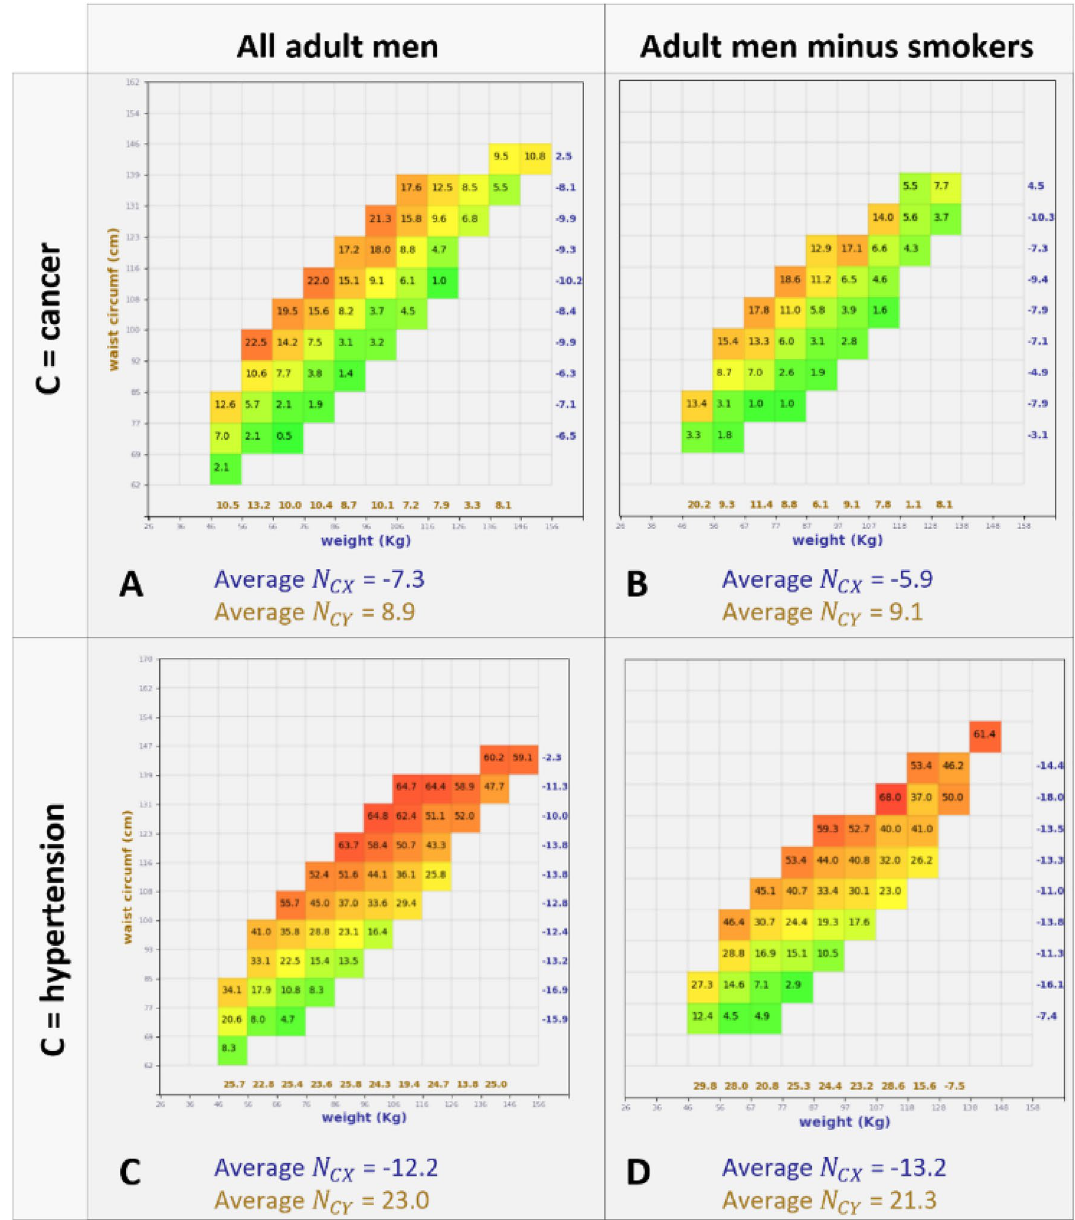
Figure 4. Prevalence maps and average NORSE scores for X = Weight, Y = Waist, C = cancer, for adult men. ( A ) including smokers. ( B ) excluding smokers. ( C , D ) Same as above but for